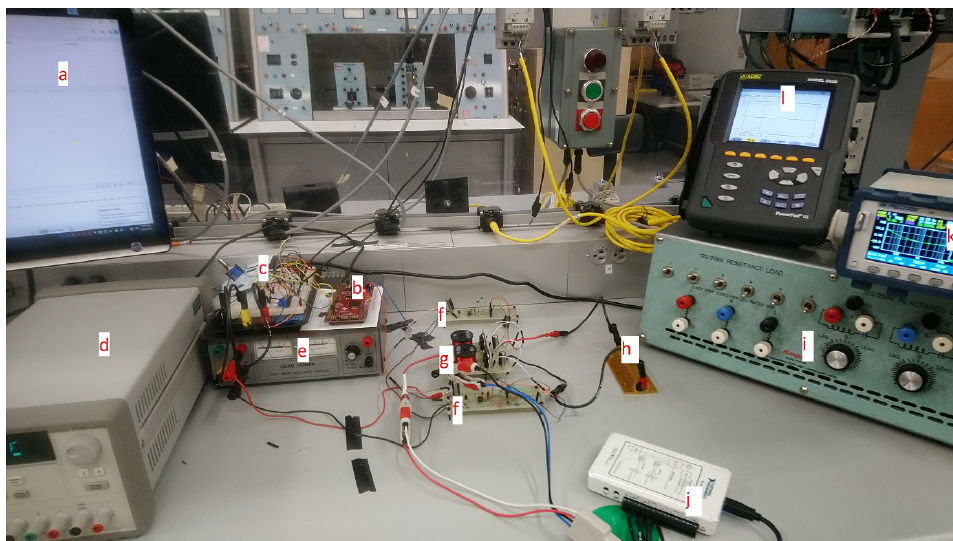
Figure 22. Experiment testbed. ( a ) Code composer studio, ( b ) TI DSP, ( c ) sensor board, ( d ) DC power supply for the inverter, ( e ) sensor board power supply, ( f ) gate driver boards, ( g ) inverter, ( h ) 50 Ω load, ( i ) RLC load, ( j ) NI myDAQ for verification of G vg and G vd , ( k ) BK precision LCR meter for impedance verification, and ( l ) AEMC power quality analyzer.